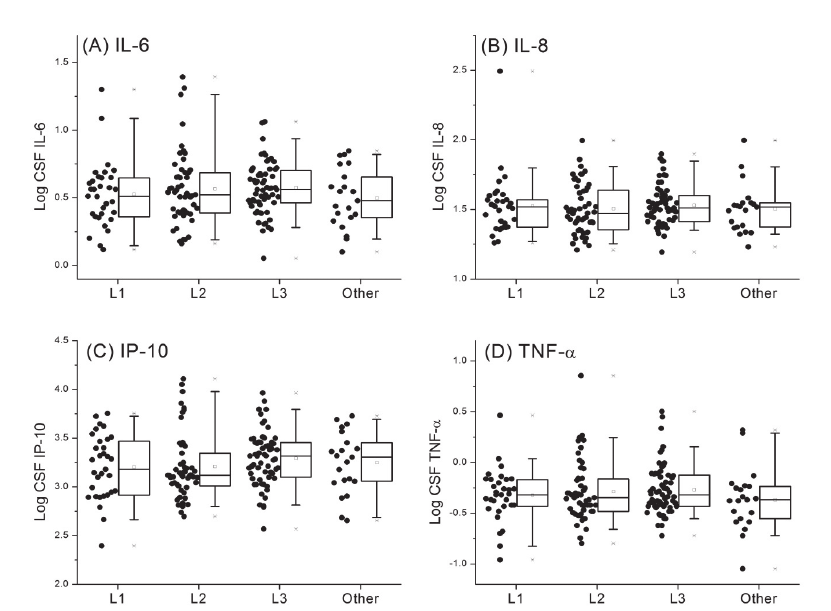
Supplemental Figure 2. Measured cytokine levels in CSF for (A) IL-6, (B) IL-8, (C) IP-10, and (D) TNF-a in participants of African ancestry. Data are shown for the major African haplogroups L1, L2, and L3. All minor haplogroups are combined into the “other”